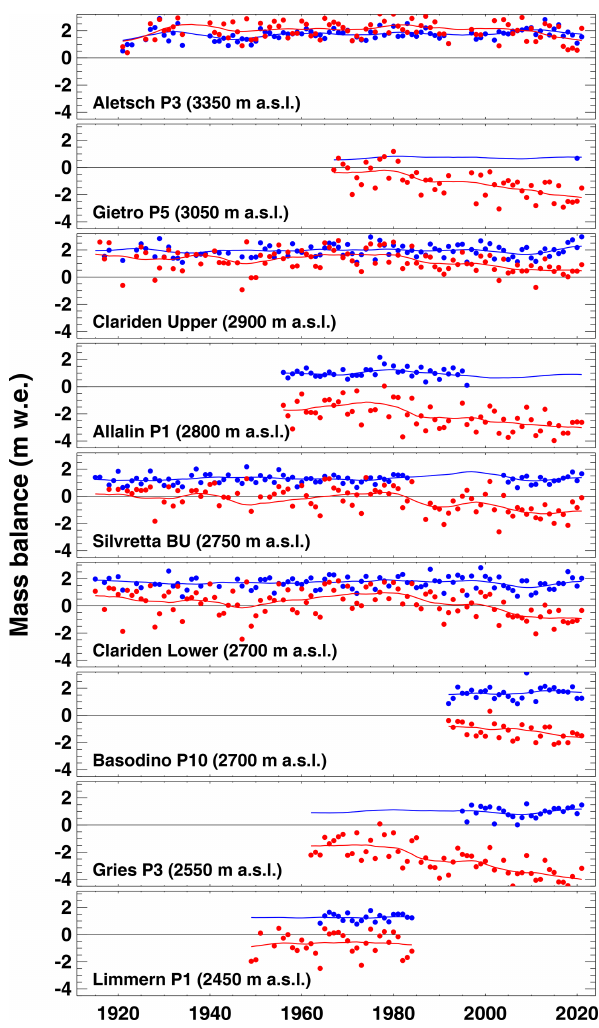
Figure 7. Evolution of the point mass balances observed at selected sites labelled with their original code (e.g. “P3” for Aletsch). Long and continuous time series at different elevations and throughout the Swiss Alps are shown. Red dots refer to observed annual mass balance and blue dots to winter balance. The lines show 11-year running means. For computing the running mean in this illustration, data gaps were filled based on the approach by Huss et al. (2009b). The sites are ordered by decreasing